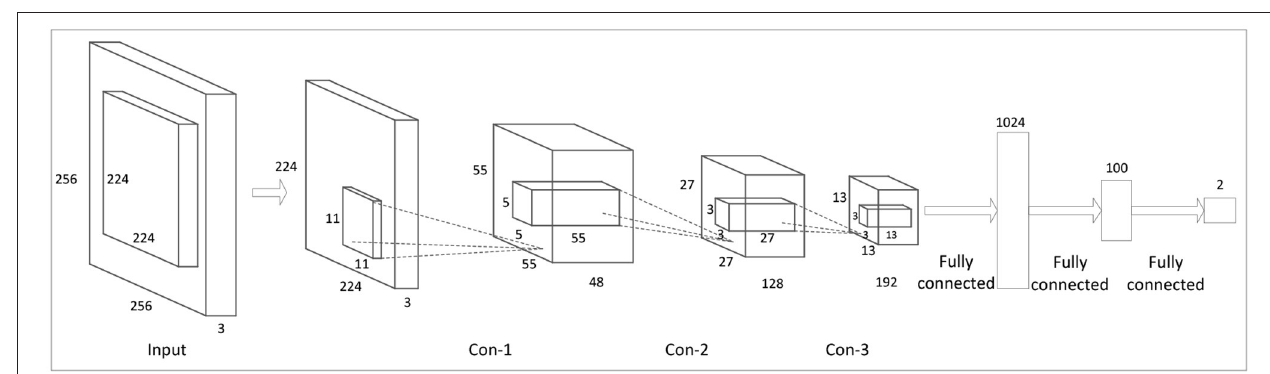
FIGURE 4 | CNN-based deep feature